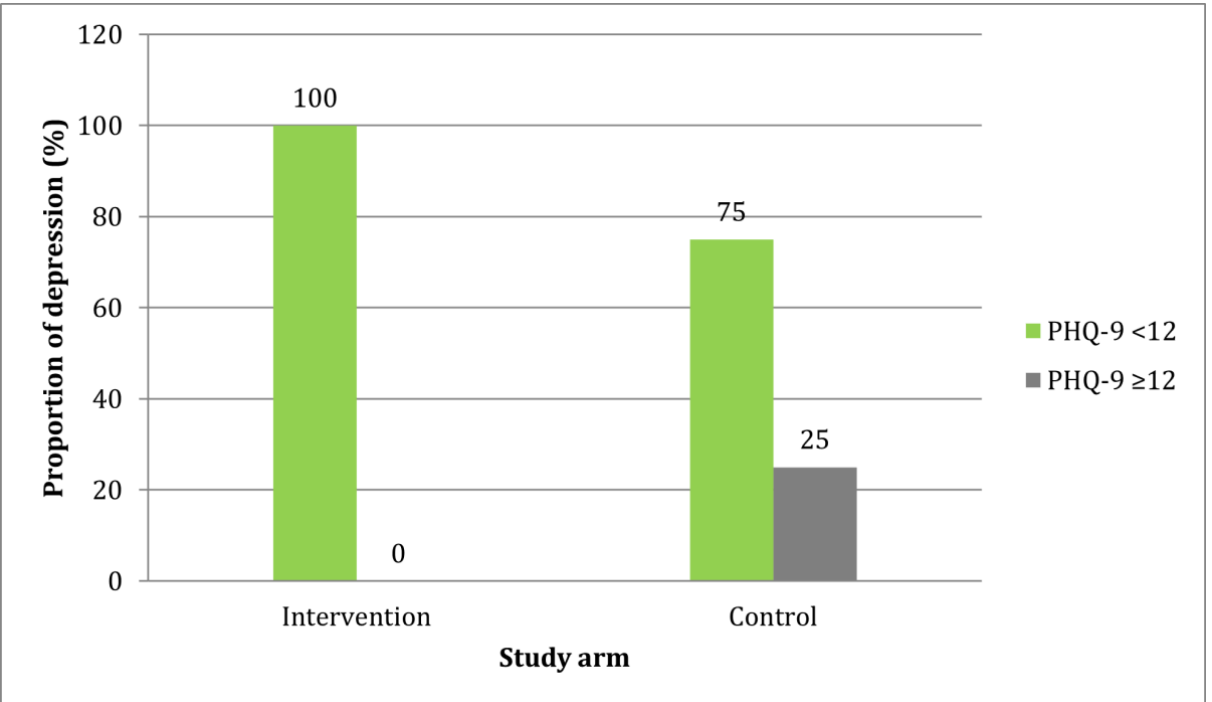
Figure 2. Comparison of the postintervention proportions of depression between the two study arms using the chi-square test. PHQ-9: Patient